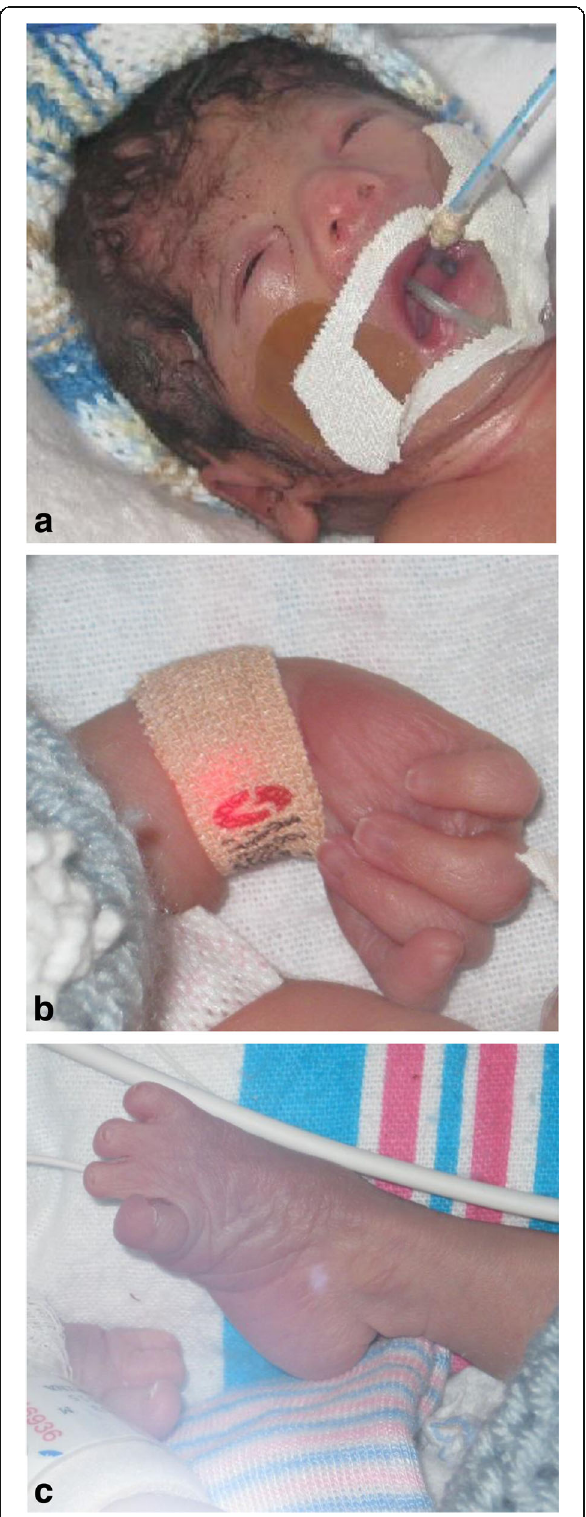
Fig. 1 Clinical features. a . Features including brachycephaly, low set ears consistent with previous patients reported with TARP syndrome. b . Absent thumb. c . Aplasia of first